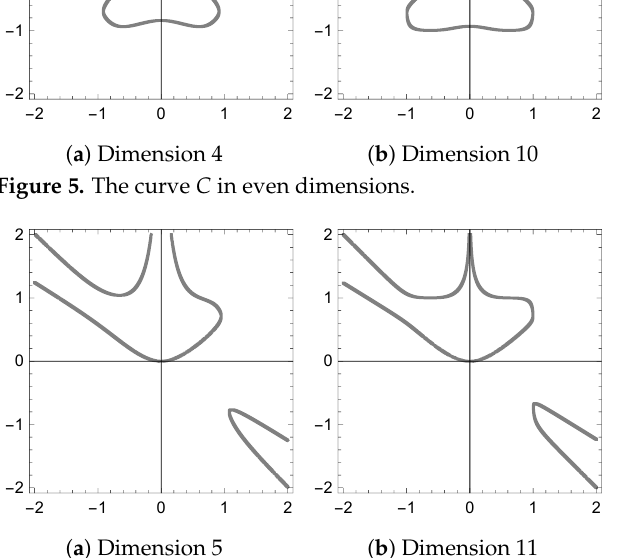
Figure 6. The curve C in odd